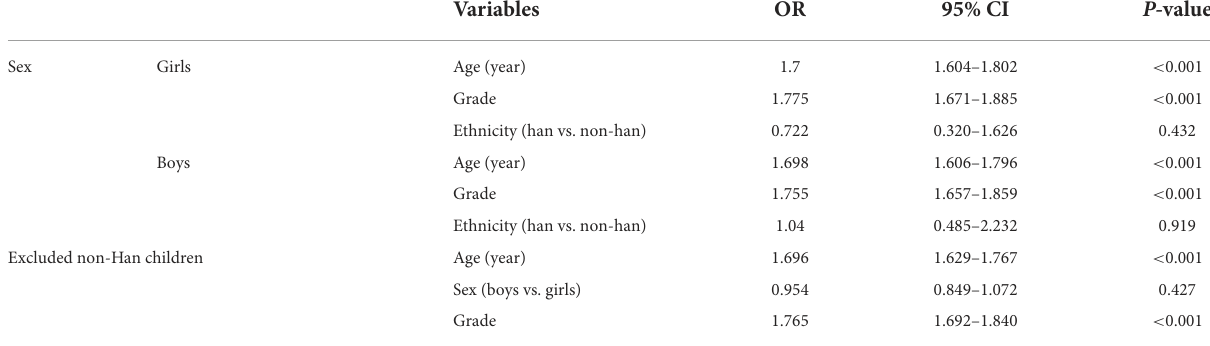
TABLE 5 Detail of sensitivity analyses of logistic regression models in all